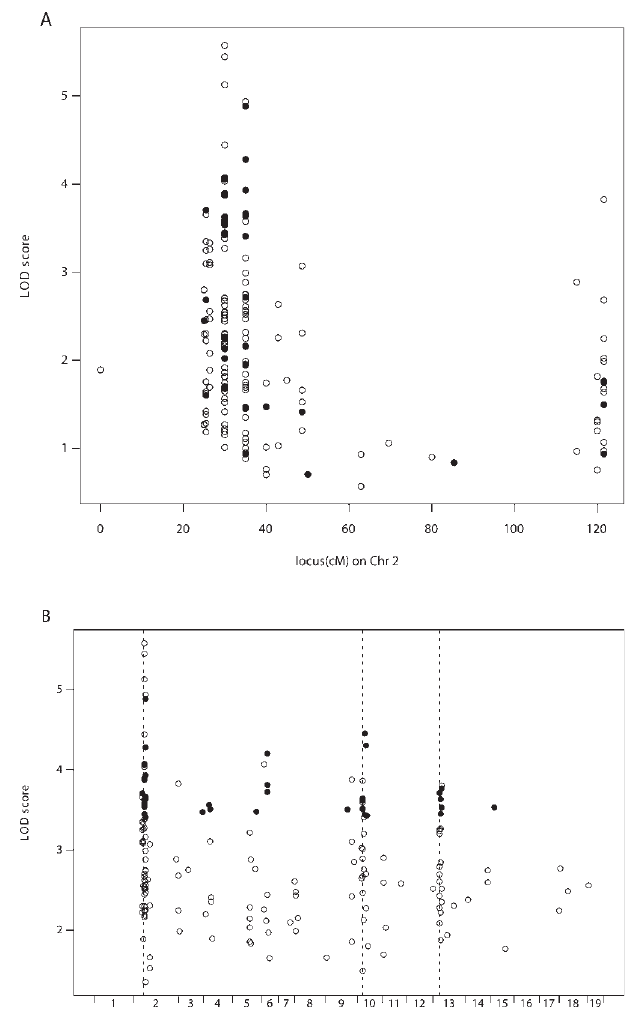
Figure 3. An Expression Quantitative Trait Locus on Chromosome 2 Regulates Many GPCR Protein Pathway Genes (A) Comapping of GPCR pathway traits to loci on Chromosome 2. The figure shows the peaks on Chromosome 2 versus LOD score for 174 GPCR protein signaling pathway traits. The closed circles correspond to 38 seed traits. (B) Comapping of GPCR pathway traits. The figure shows the magnitude (y-axis) versus location of LOD peaks (x-axis is scaled by cM) for 174 GPCR protein signaling pathway traits. The closed circles correspond to the 38 seed traits. The interval mapping LOD profiles for all 38 seeds are included in Figure S2. DOI: